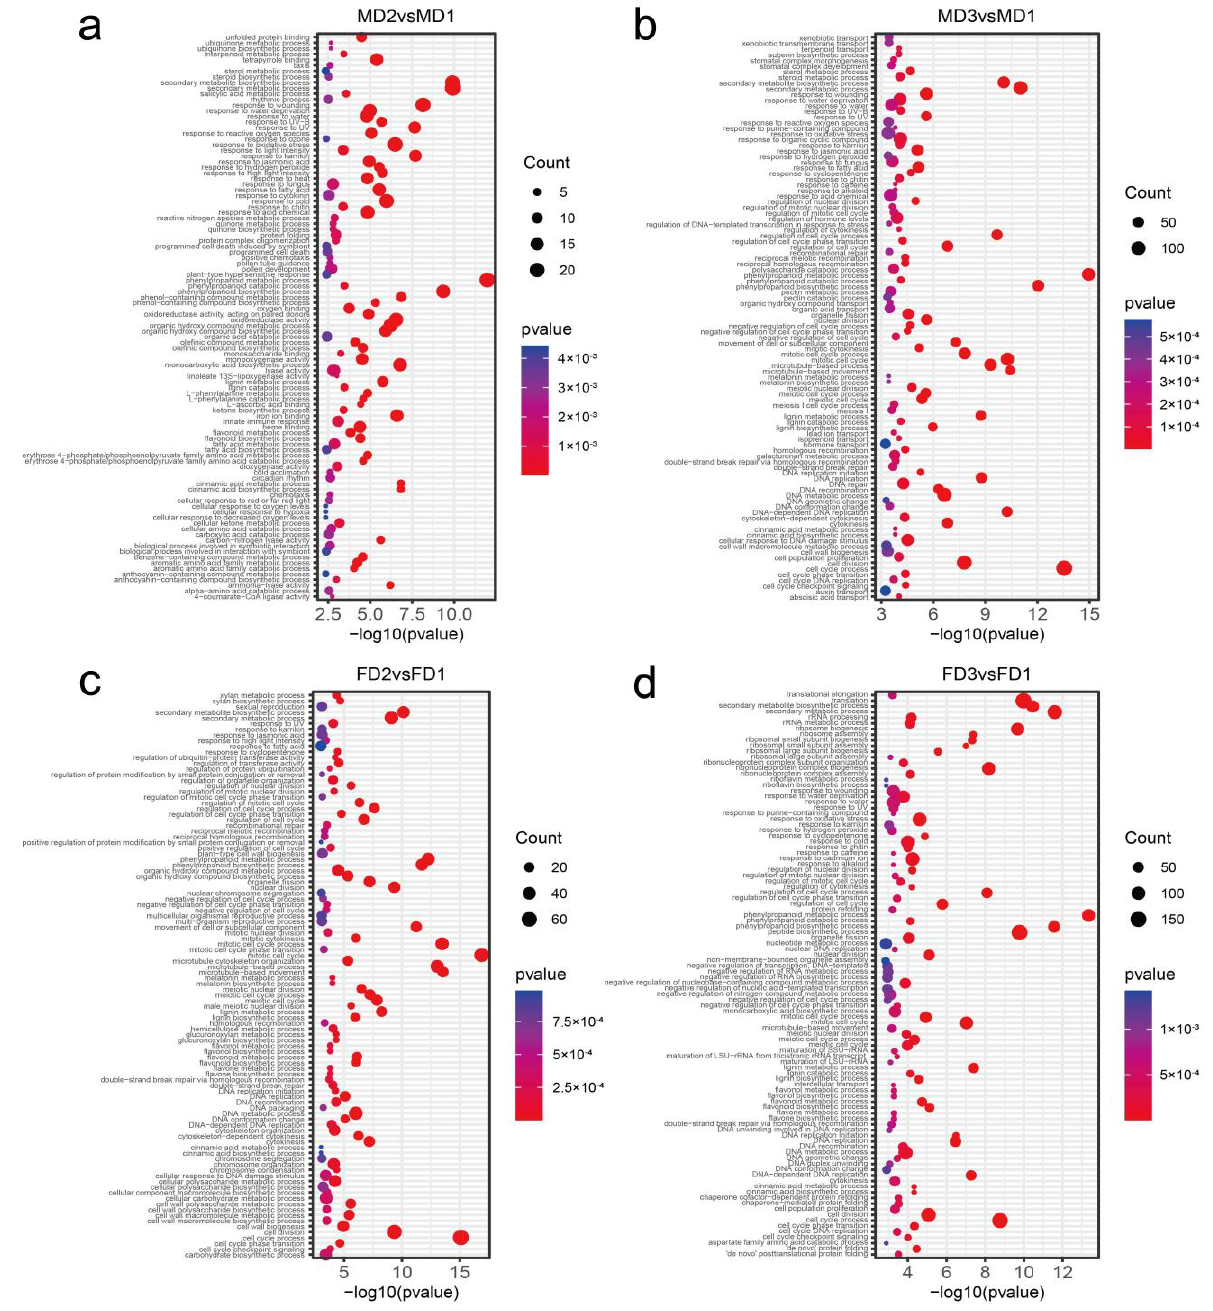
Figure 8. GO (biological process) enrichment analysis of differential genes in male and female flower buds development. The top row ( a , b ) shows GOs enriched in male flower buds at the formation of flower primordial (MD2) and stamen primordia (MD3) stages. Enriched GO for the formation of the flower primordial (FD2) and the pistil primordia (FD3) stages of female flower buds are shown in the bottom row ( c , d ). The top 100 enriched GO terms are presented in each comparison. The vertical and horizontal axes are enriched GO terms and the enrichment factor uniqueness, respectively. The unit of the scale bar is log 10 p -value. The node size indicates the number of genes of the enriched GO